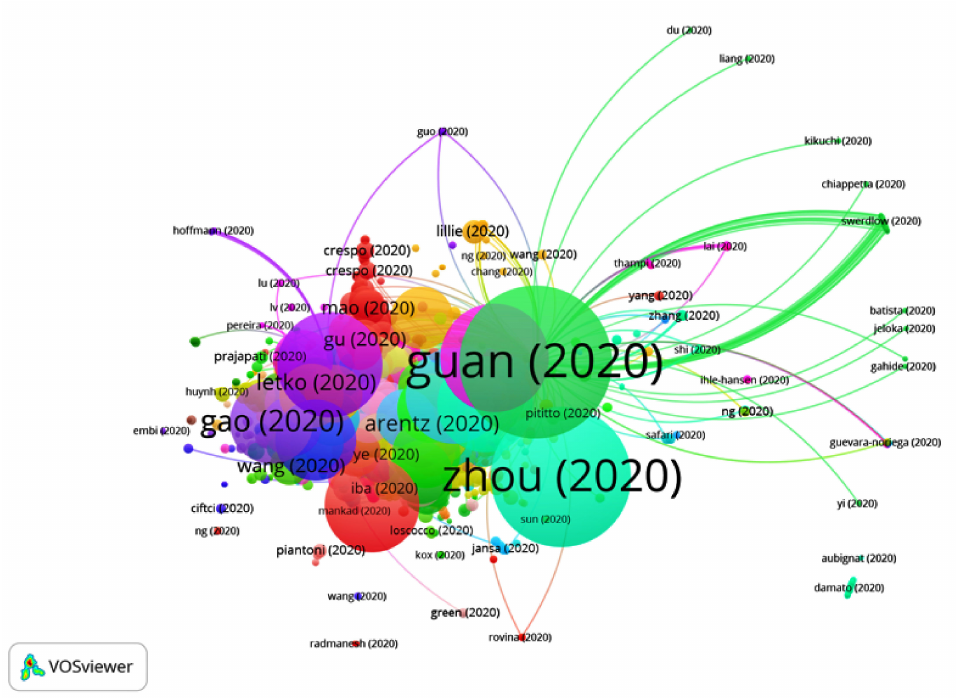
Figure 17. Citation network from the sub-clusters in Group 1.